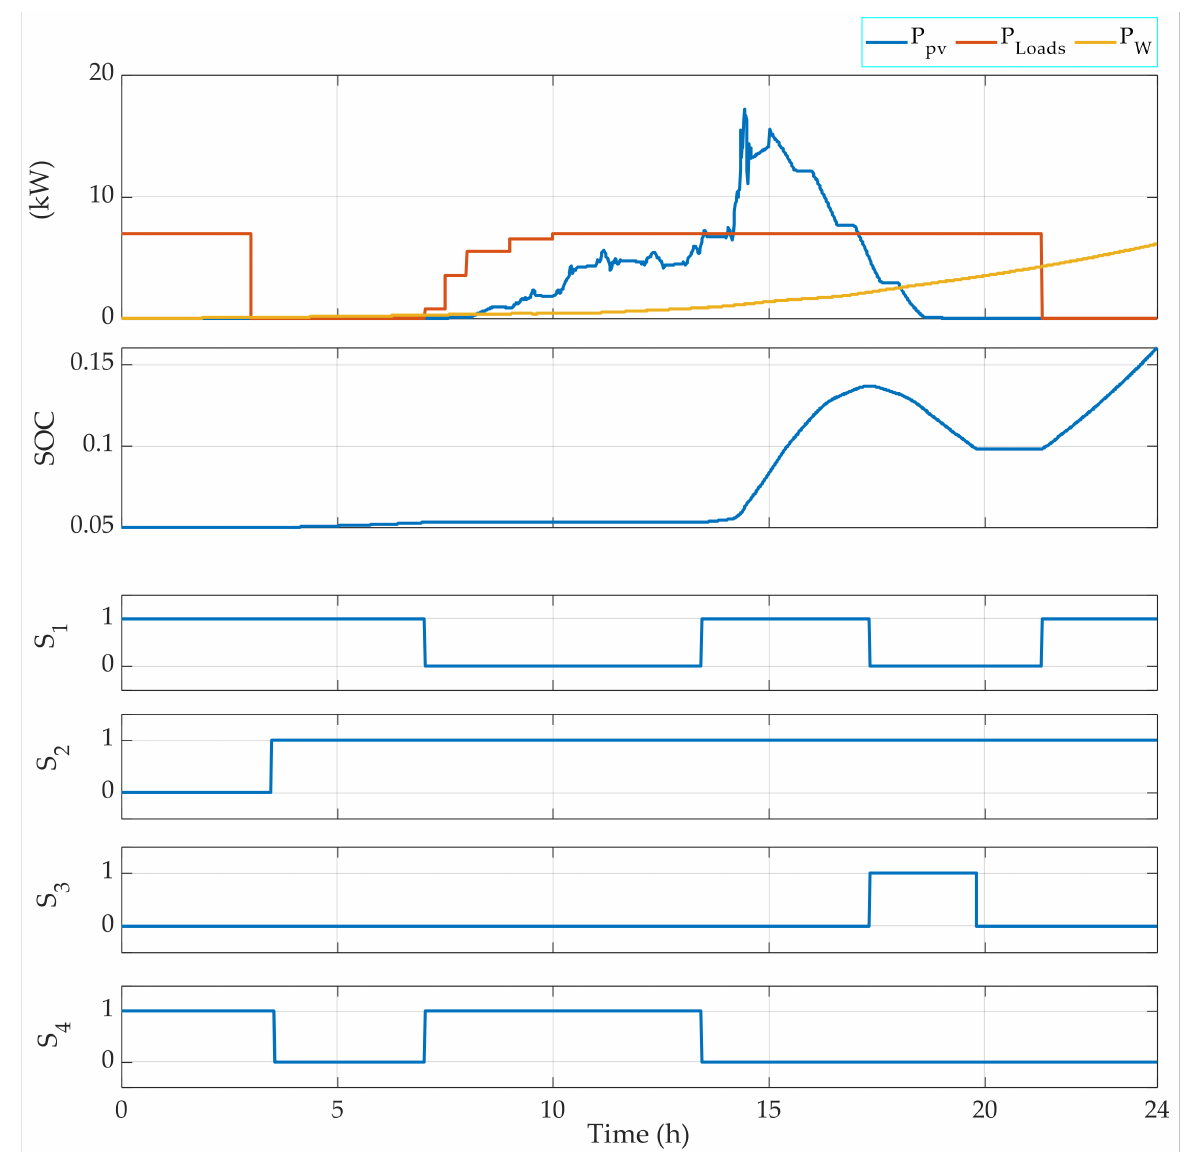
Figure 6. EMS results for the photovoltaic system in March using a variable loads power using an initially fully discharged battery